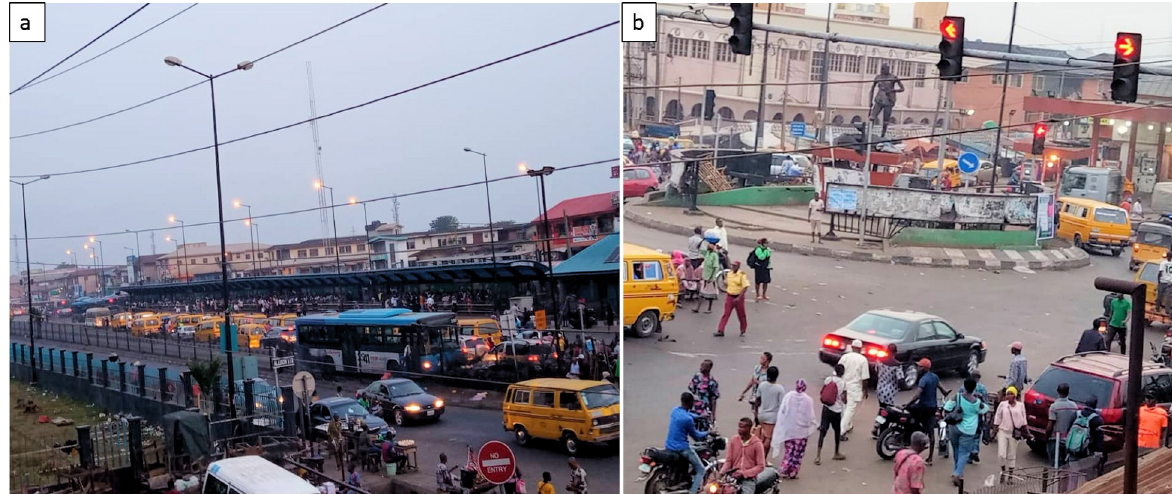
Fig. 10. Some parts of Ikorodu LGA. a – Sprawl in Ikorodu driven partly by the construction of dual-carriage main access; b – Ikorodu Bus stop/garage (year